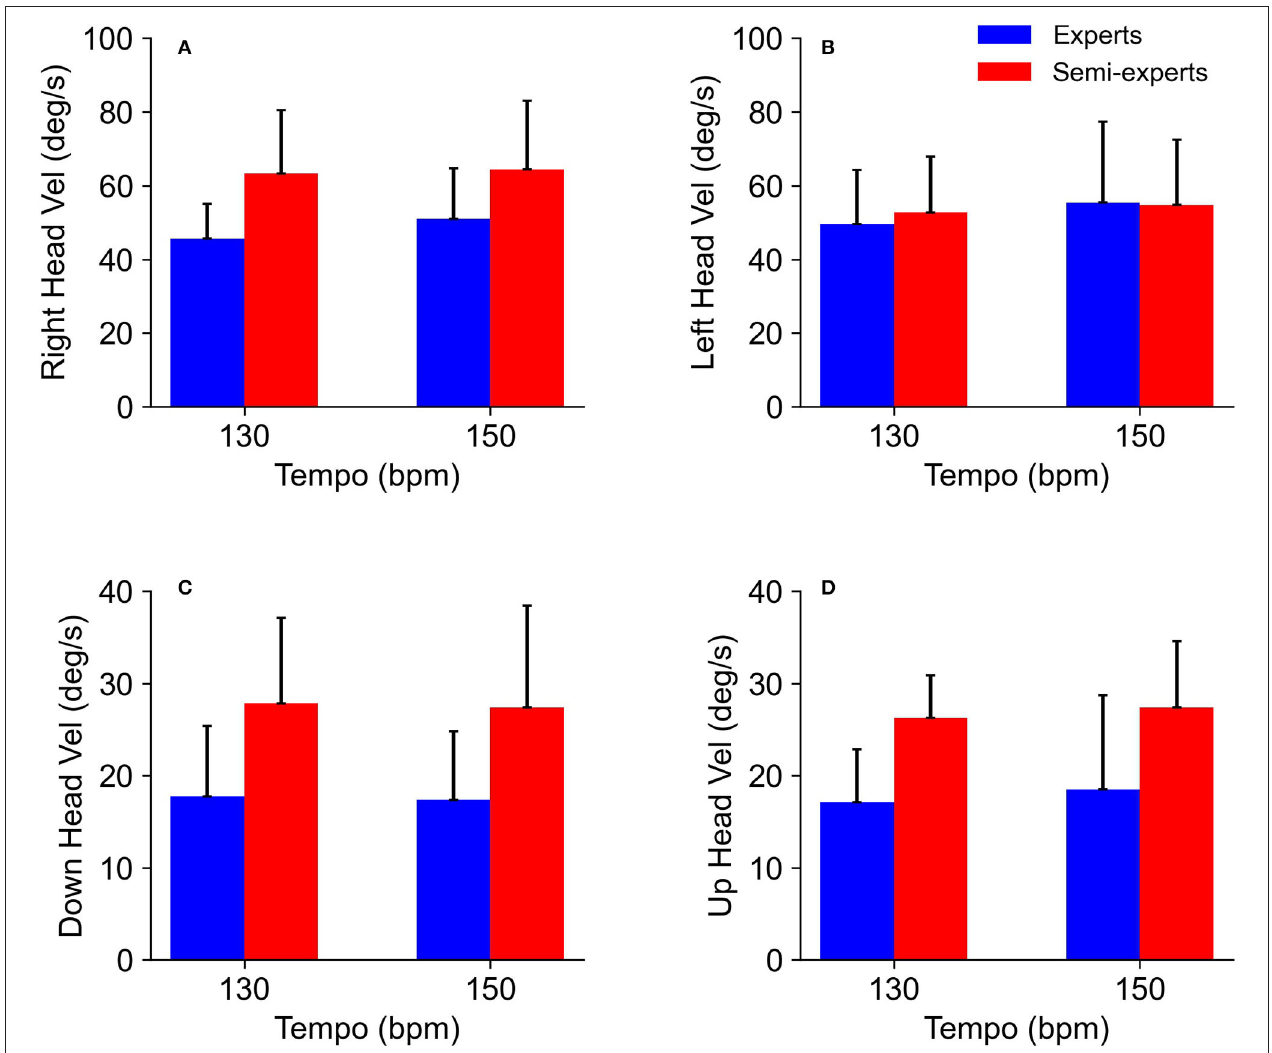
FIGURE 6 | Comparison of the head velocity of the expert and semi-expert groups in the two tempo conditions. (A) Comparison of the rightward head velocity (right head vel), (B) leftward head velocity (left head vel), (C) downward head velocity (down head vel) and, (D) upward head velocity (up head vel) between the experts and semi-experts in the two tempo conditions are